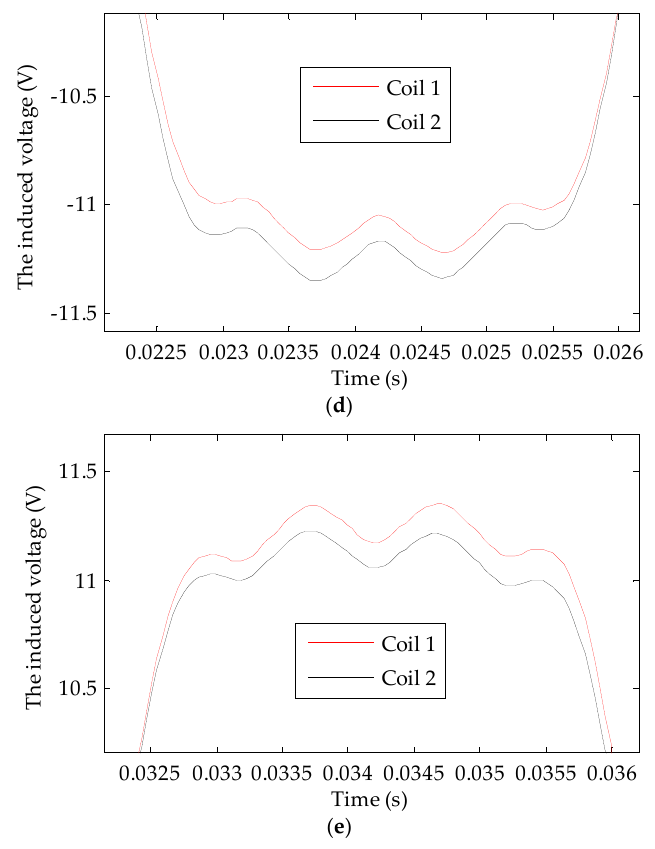
Figure 9. Induced voltage curves for both detection coils at the dynamic eccentricity of 45° under no-load: ( a ) global map; ( b ) local map 1; ( c ) local map 2; ( d ) local map 3; ( e ) local map 4.